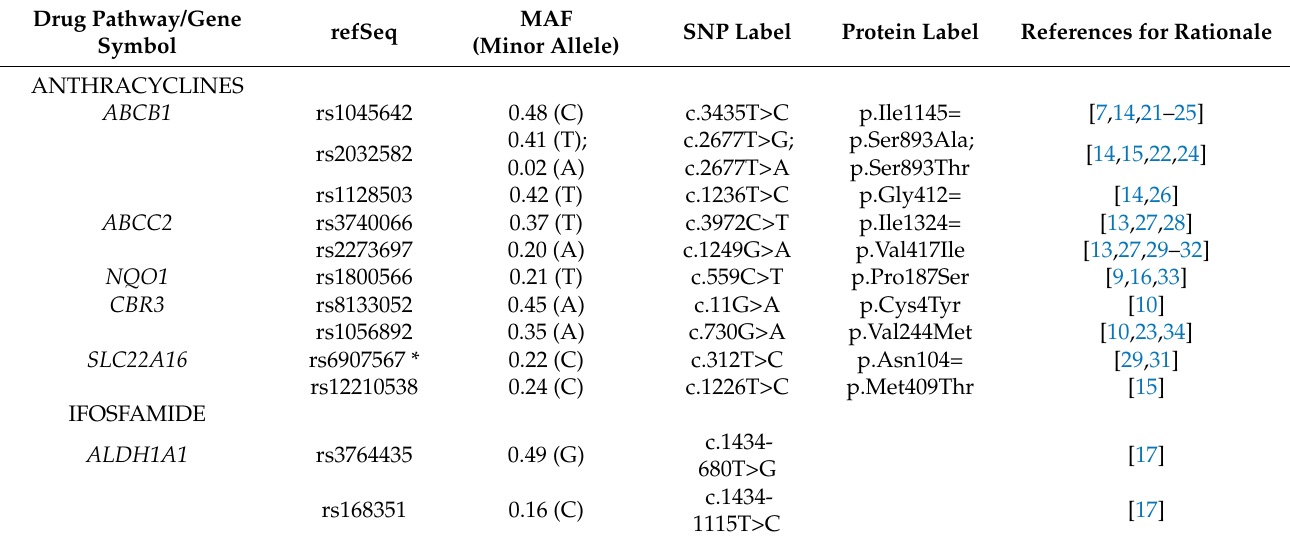
Table 2. Selected single nucleotide polymorphisms (SNPs) in anthracycline and ifosfamide drug